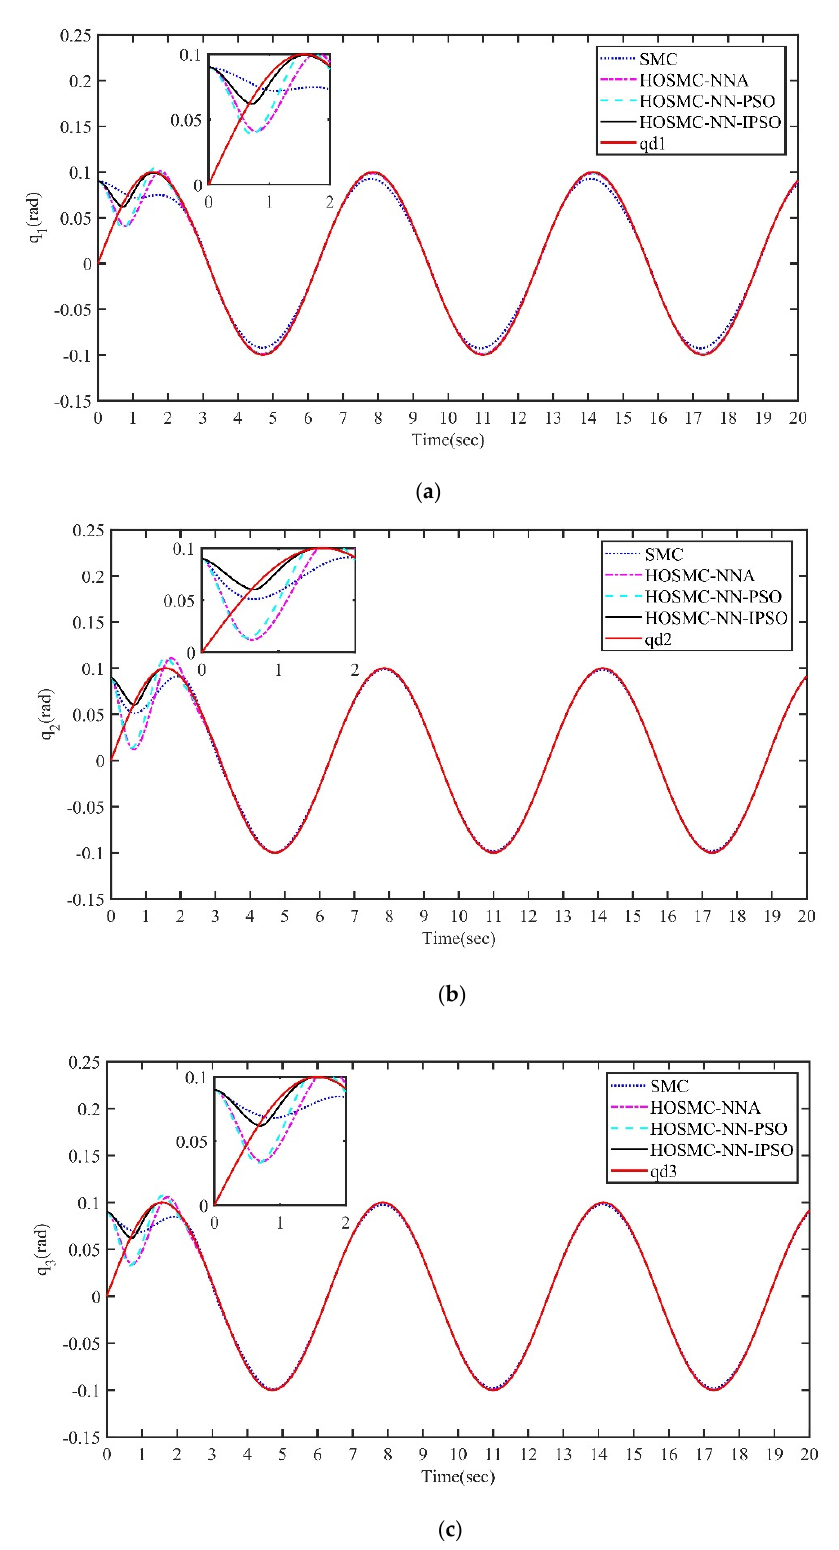
Figure 4. Position tracking of the joints under the SMC, HOSMC − NNA, HOSMC − NN − PSO and HOSMC − NN − IPSO controllers. ( a ) Position tracking of the joint 1. ( b ) Position tracking of the joint 2. ( c ) Position tracking of the joint